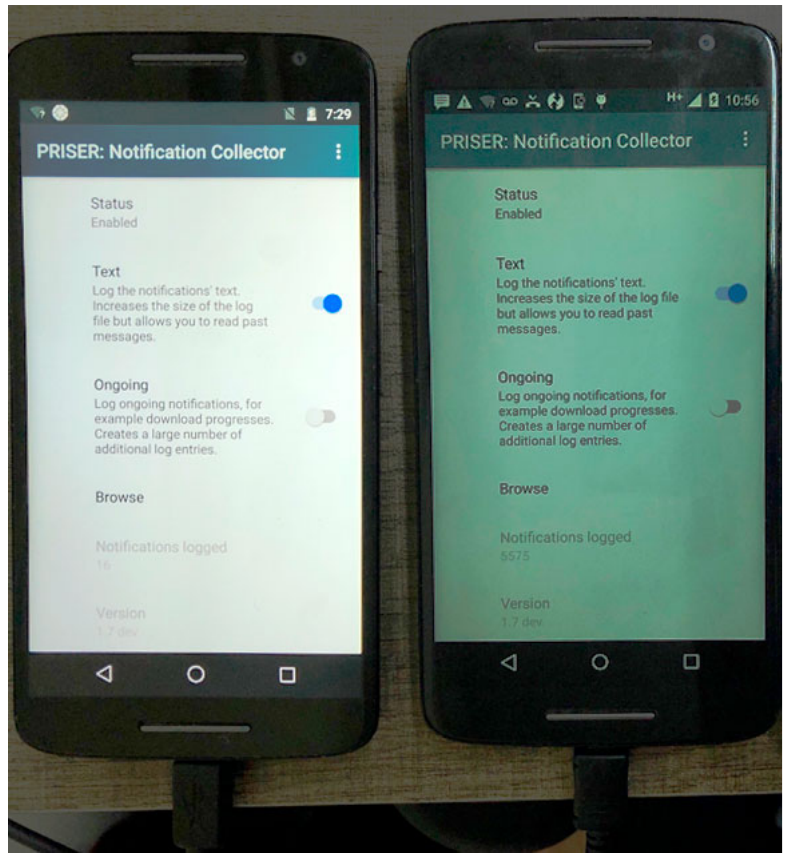
Figure 6. Devices used for primary